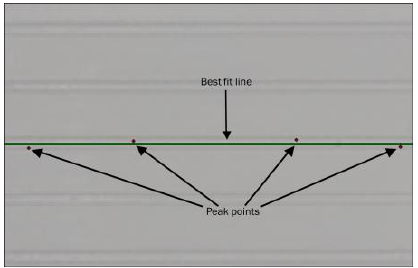
Figure 8: Peak points and